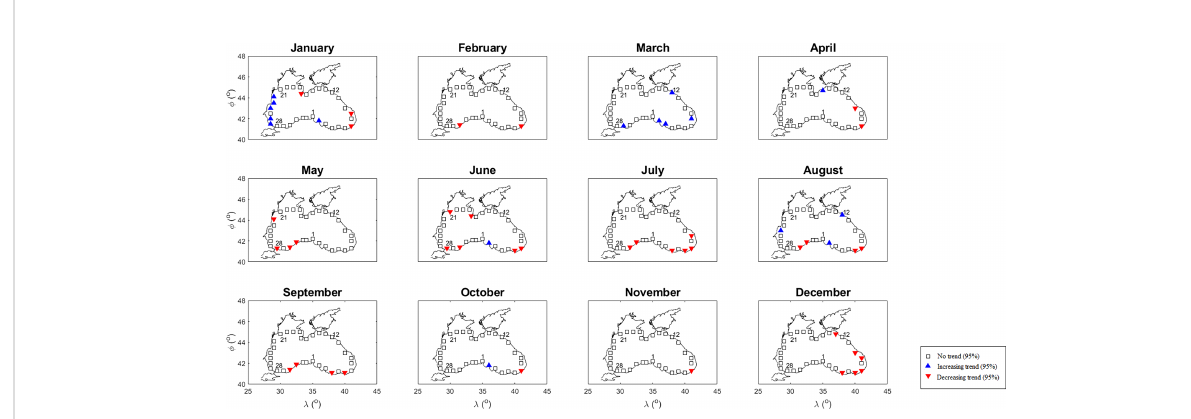
FIGURE 5 Mann-Kendall results for monthly maximum WSs during 42 years between 1979 and 2020.